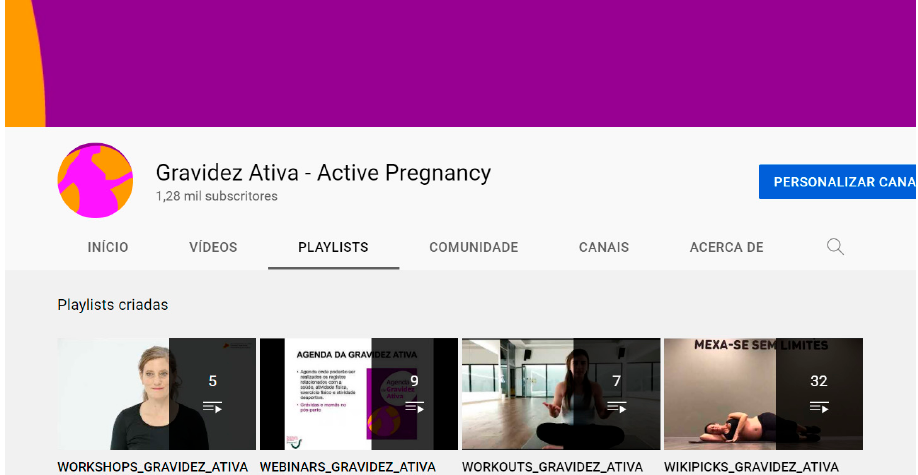
Figure 2. Layout of the Active Pregnancy YouTube